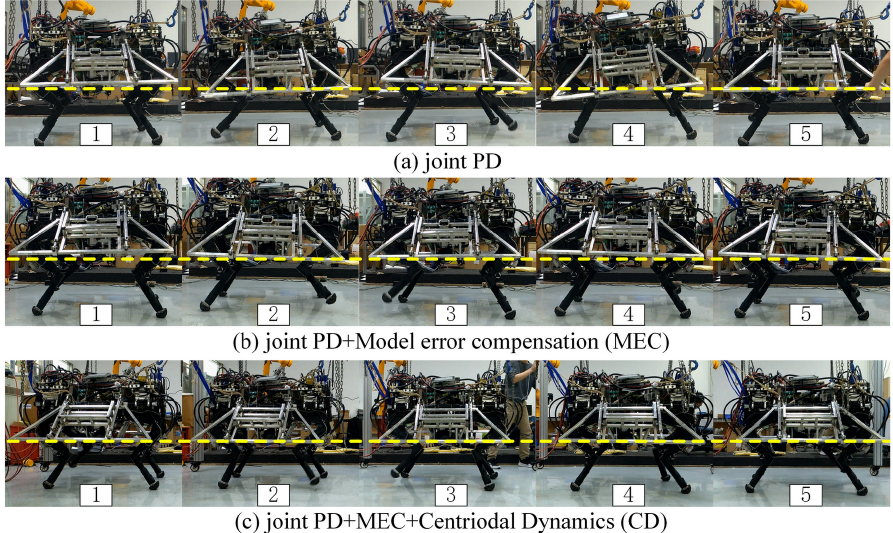
Figure 8. Snapshots of experimental trials with three